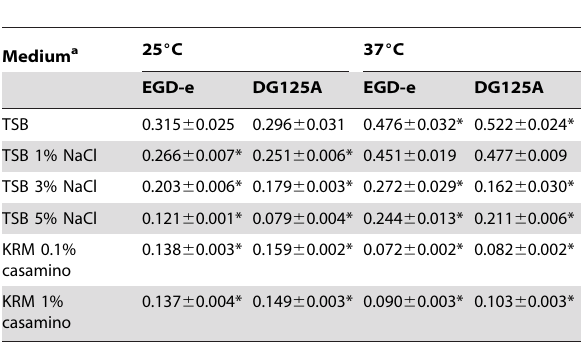
Table 2. Growth rates (h 2 1 ) of L. monocytogenes EGD-e and L. monocytogenes DG125A during incubation at 25 u C and 37 u C in complex and defined